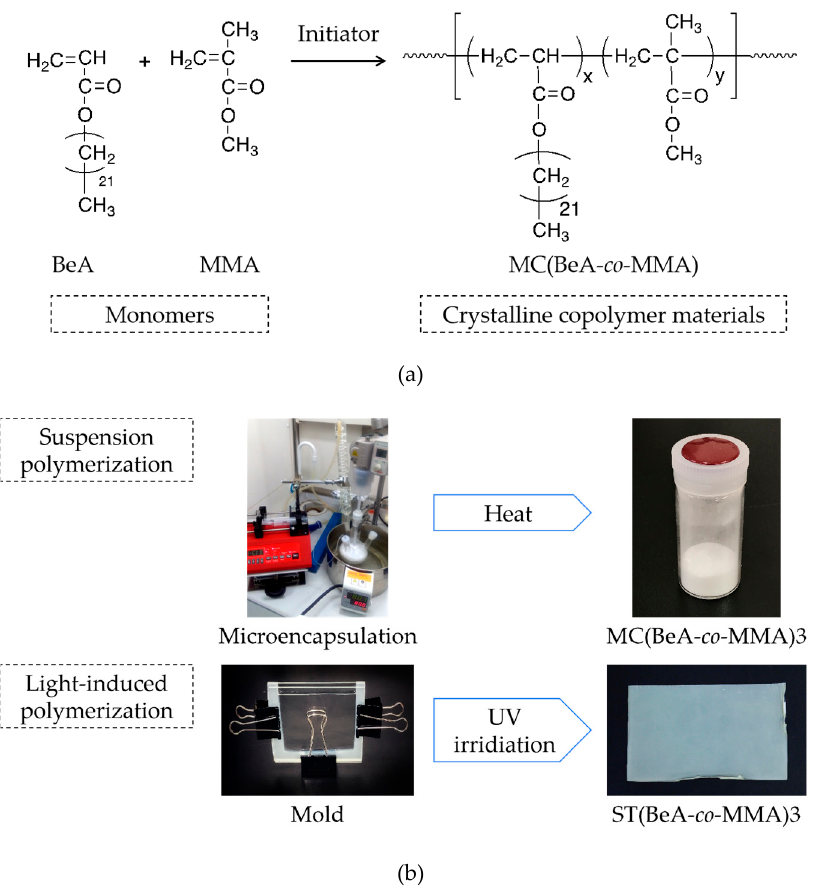
Figure 1. Synthesis schemes of thermoregulation MC(BeA- co -MMA) copolymer ( a ), and the microcapsules and sheets prepared through suspension and light-induced polymerization, respectively ( b ). The phase transition between the crystal phase and the isotropic phase promises the energy storage capacity.